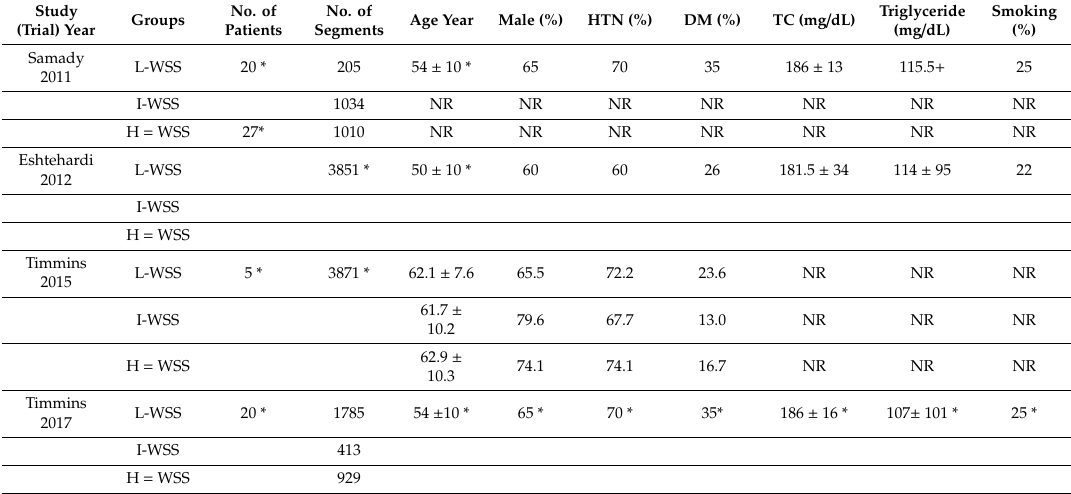
Table 2. Main characteristics of patients enrolled among trials included in the